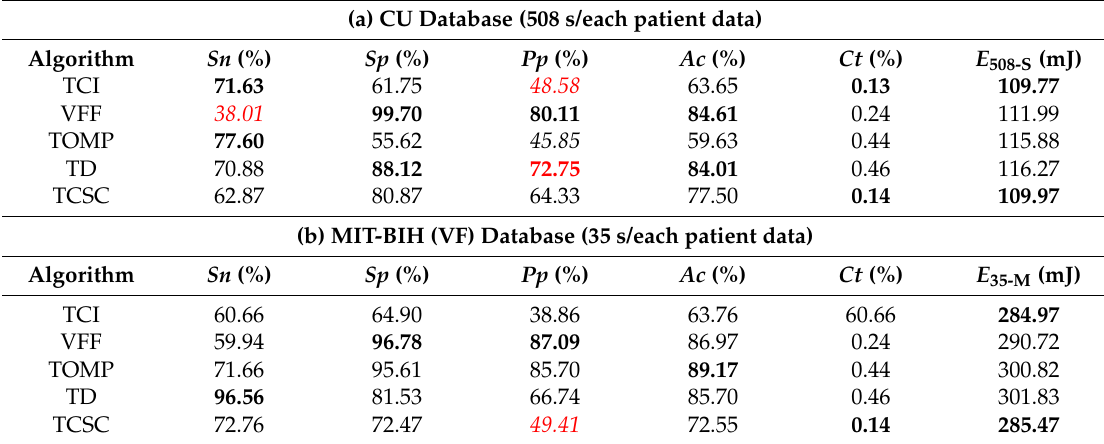
Table 4. Summary of performance for different VF detection algorithms running in a microcontroller.